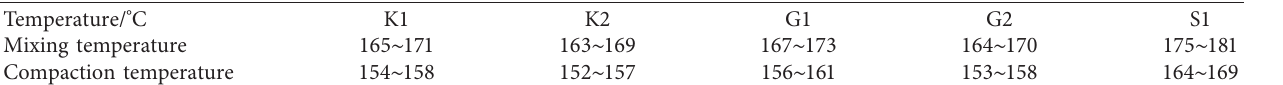
Table 4: Construction temperature.